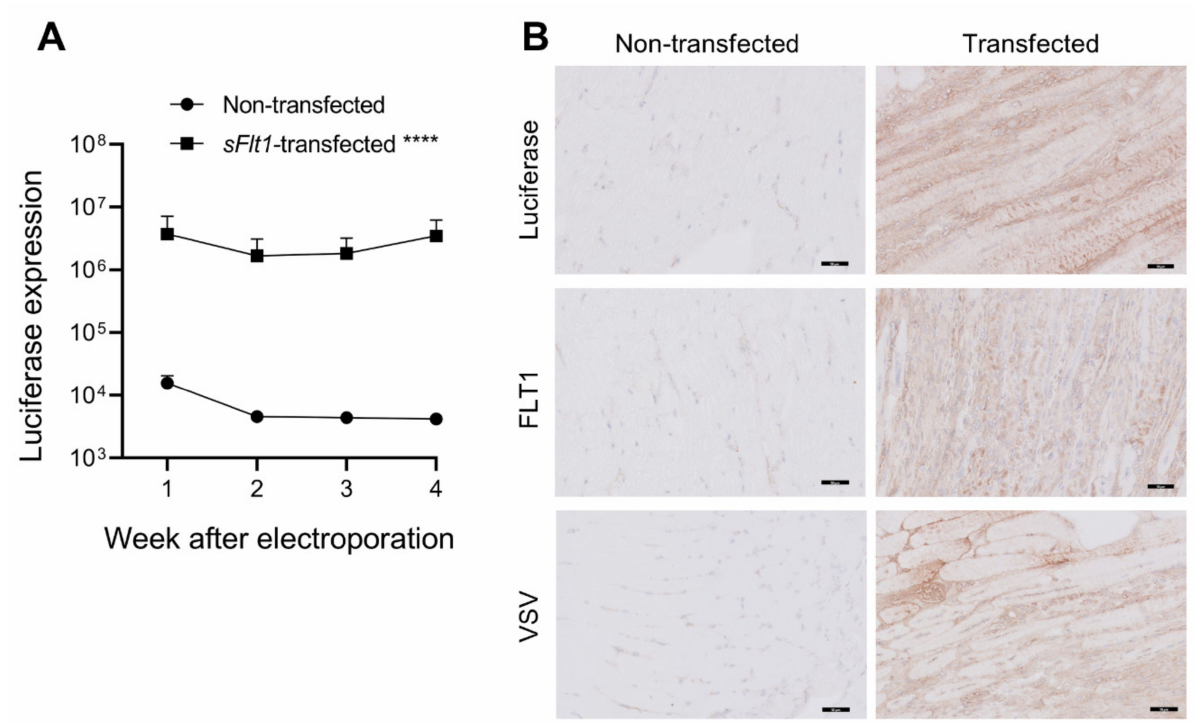
Figure 1. Transfection efficiency. ( A ) The sFlt1-VSV and luciferase constructs were co-transfected by injection into the calf muscles. Following an intraperitoneal injection of luciferin, luciferase expression was measured using a NightOWL bioluminescence camera. Measurement of the total flux (photons/s) showed efficient transfection at all indicated timepoints. **** p < 0.0001 versus non-transfected mice, linear mixed model using log-transformed luciferase levels. ( B ) Representative images of luciferase, FLT1 and VSV-G immunostaining of calf muscle tissues 4 weeks after electroporation shows positively stained areas in transfected mice, but not in non-transfected